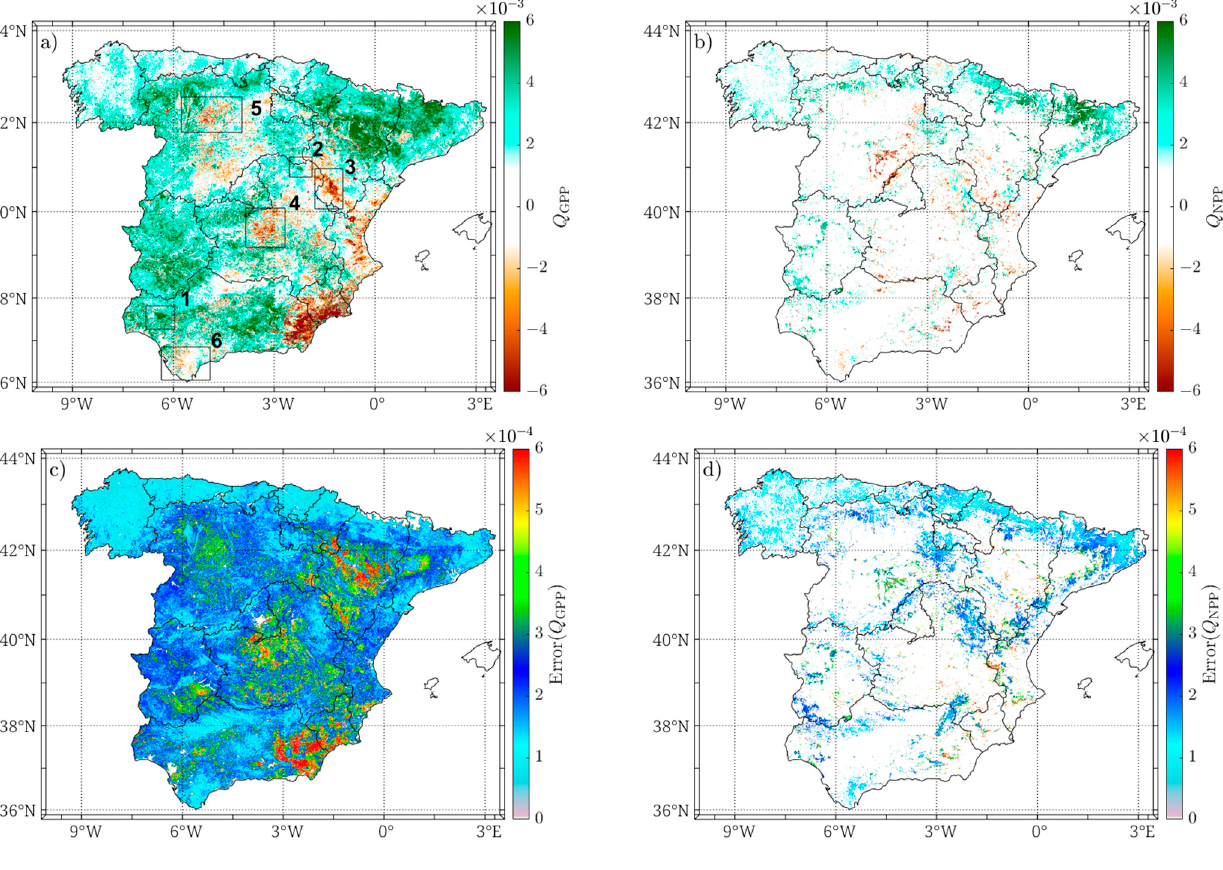
Figure 5. GPP ( a ) and NPP ( b ) normalized trends ( Q GPP and Q NPP ) at a significance level of p- value < 0.1 across the period 2004–2018. The error associated with Q GPP ( c ) and Q NPP ( d ) is also included. White color refers to pixels with a slope that is very small or pixels with a nonsignificant Mann–Kendall test value (0 value). For NPP, white color also refers to non-forest pixels.